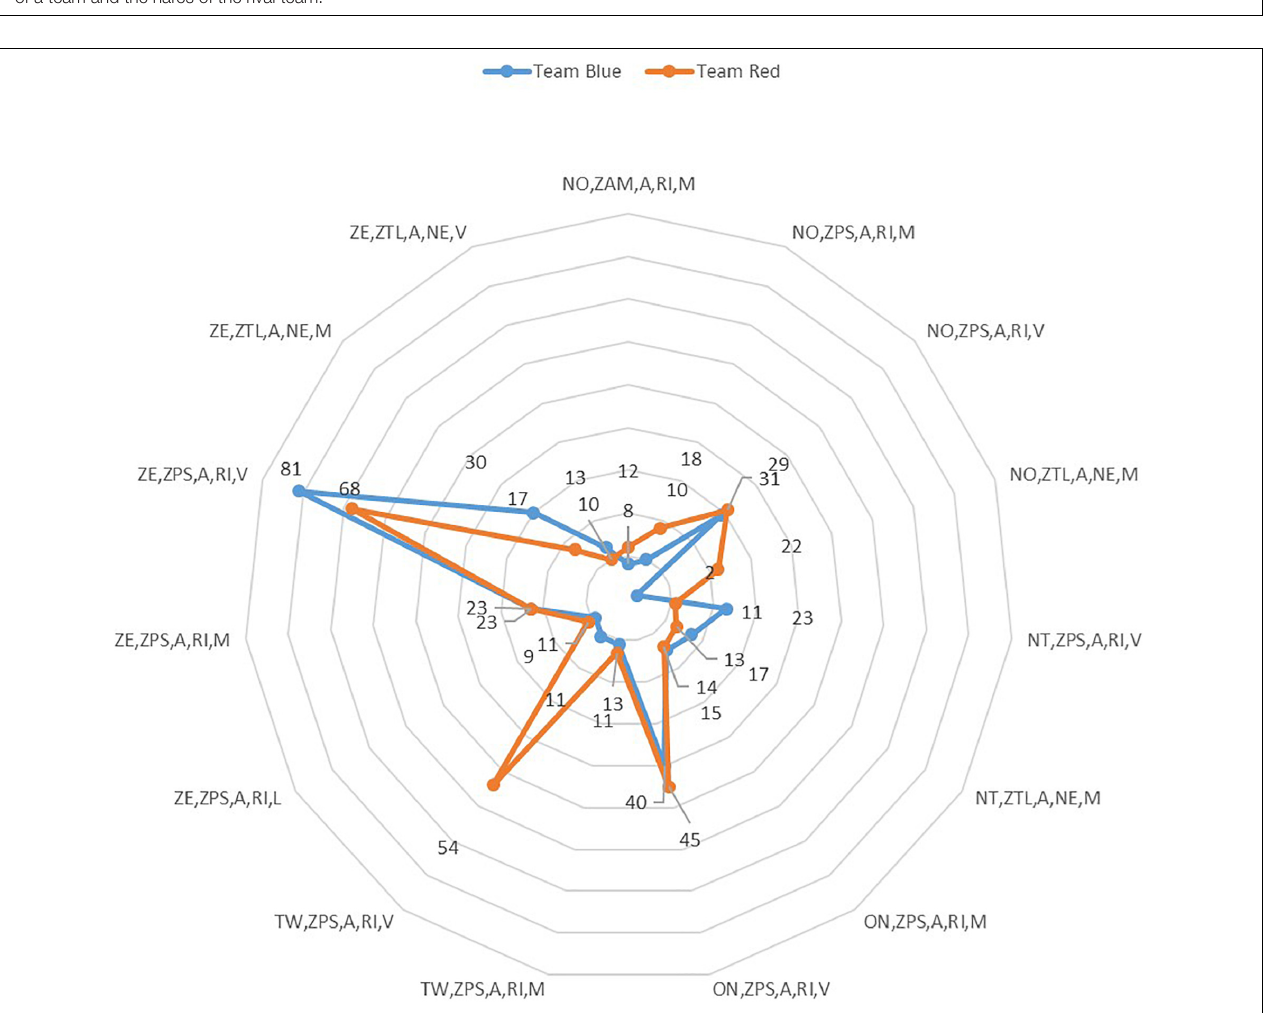
Figure 8 shows the strategic forms of both teams. The sets of variables (frequencies) most used by the teams (=2% intra- role: